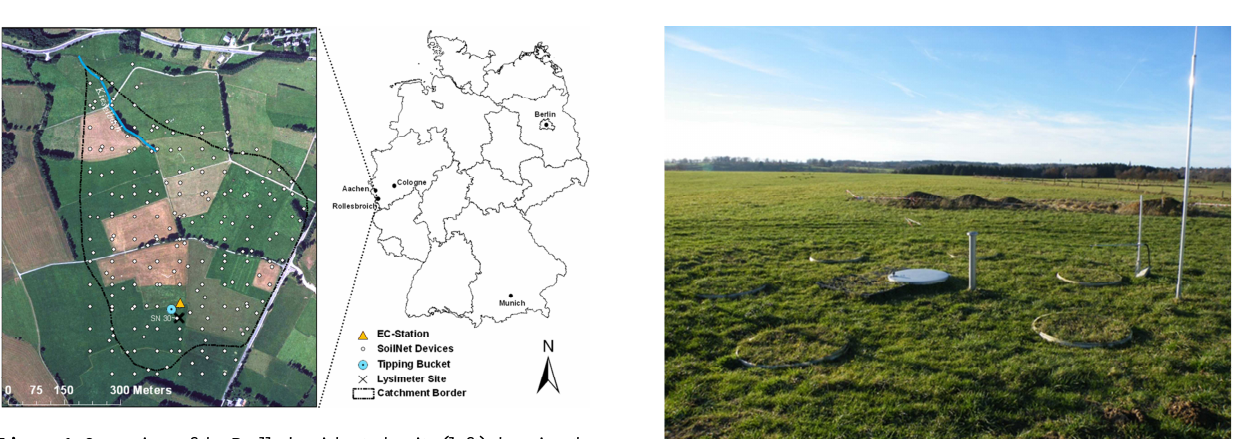
Figure 1. Overview of the Rollesbroich study site (left) showing the locations of the lysimeter, the rain gauge, the eddy covariance sta- tion, the catchment boundaries, and the SoilNet devices. All devices are arranged within a radius of 50m including the nearest SoilNet device (SN30) for comparison of temperature and soil water content with the surrounding field. The map on the right shows the location of the Rollesbroich catchment in Germany.